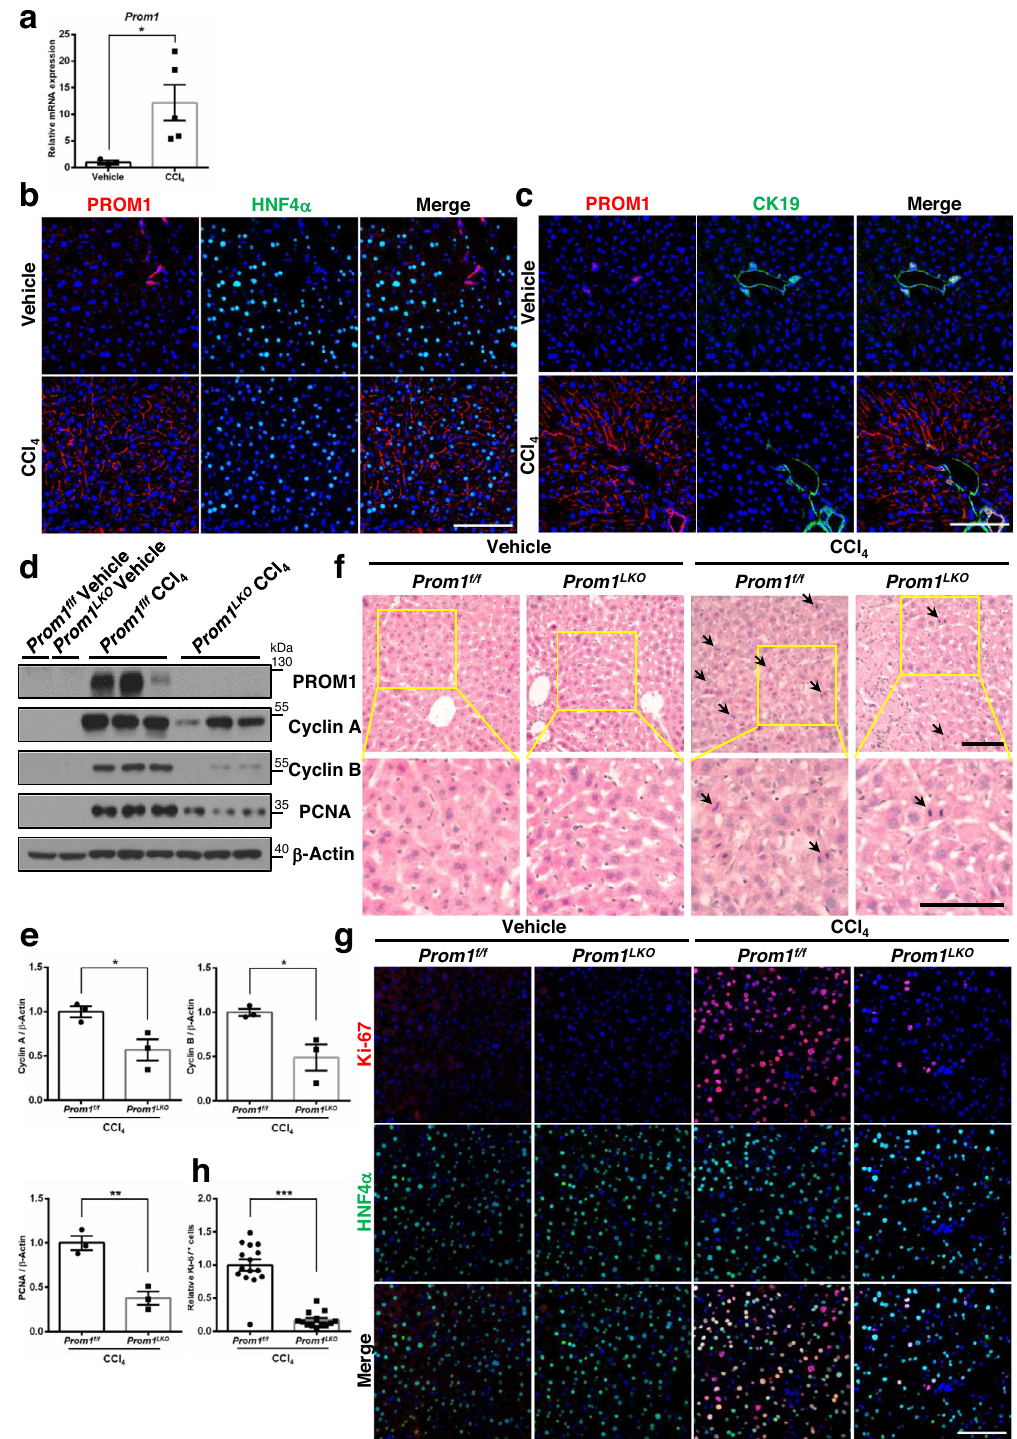
Fig.3|Liver-speci fi cdeletionofProm1inmiceimpairsliverregenerationafter CCl 4 injection. Eight-week-old male Prom1 f/f and Prom1 LKO mice were intraper- itoneally injected with vehicle ( n =3) or CCl 4 ( n =5) for 48hours. The liver was analyzed by qRT-PCR, immunoblotting and immuno fl uorescence. a The relative mRNA level for PROM1. The mRNA level of PROM1 was normalized by 18S rRNA ( p =0.028). b, c Double immuno fl uorescence for PROM1 and ΗΝ F4 α ( b ) or CK19 ( c ). The experiment was repeated independently three times with similar results. d Immunoblotting for PROM1, Cyclin A and B, and PCNA. e Statistical analysis of the band intensity in d ( n =3, p =0.033 for Cyclin A, p =0.029 for Cyclin B,